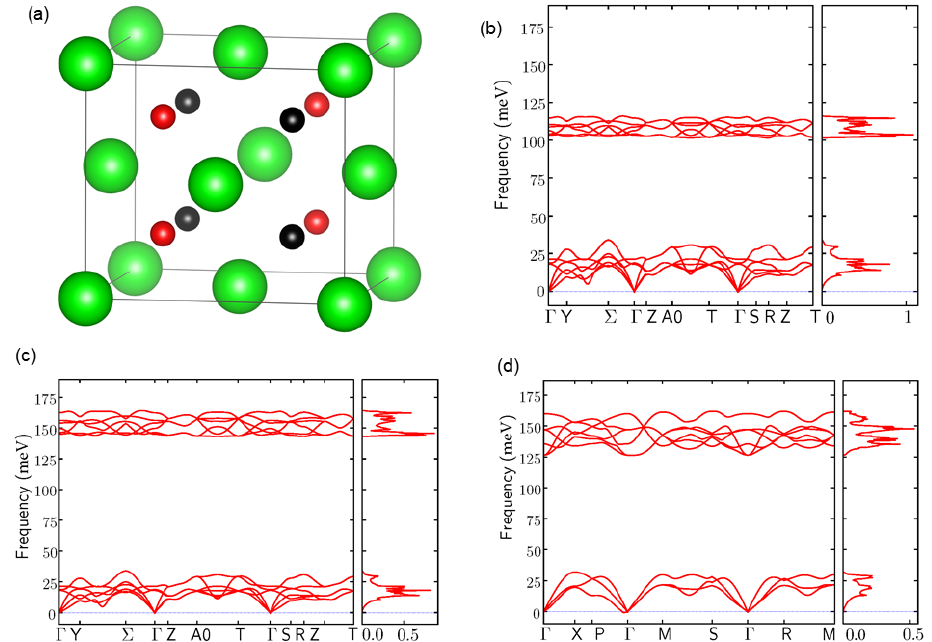
Figure 1. ( a ) Crystal unit cells for (cid:15) -ZrH 2 (space group I4/mmm), γ -ZrH, and γ -ZrD (both are of space group Cccm), where Zr atoms are in green, H(D) atoms in red exist in all structures, and H(D) atoms in black only exist in (cid:15) -ZrH 2 . It should be pointed out that lattice constants are different between (cid:15) -ZrH 2 and γ -ZrD(H). Figures were drawn using the VESTA program [35]. ( b – d ) are calculated phonon dispersions and PDOS for the primitive cells of γ -ZrD, γ -ZrH, and (cid:15) -ZrH 2 , respectively. Note that the number of low energy bands in γ -ZrH and γ -ZrD is twice that of (cid:15) -ZrH 2 because the primitive cells are Zr 2 H 2 ,Zr 2 D 2 , and ZrH 2 for γ -ZrH, γ -ZrD, and (cid:15) -ZrH 2 , respectively. The BZ paths and notation are adopted from [36].